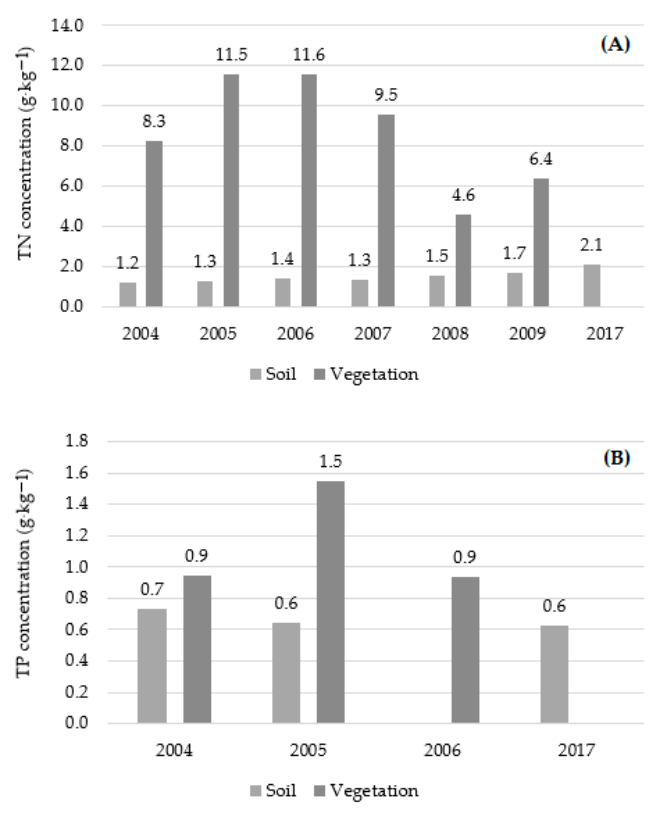
Figure 5. TN (A) and TP (B) content of the surface soil layer and vegetation in the SFCW.